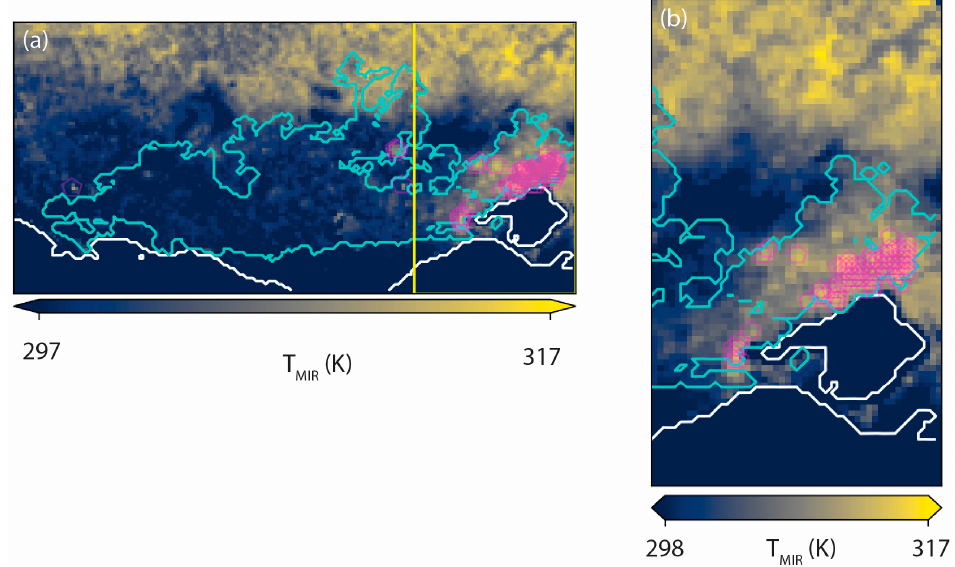
Figure 11. AHI T MIR values (at 0340Z on 20191028) overlaid with BRIGHT hotspots, magenta symbols) shown for all of the Victorian Volcanic Plain (SVP01 in biodomain SVP (Figure 6) ( a ) and a smaller zoomed in portion ( b ). Please note, the zoomed in area is indicated by the yellow outline in ( a ).